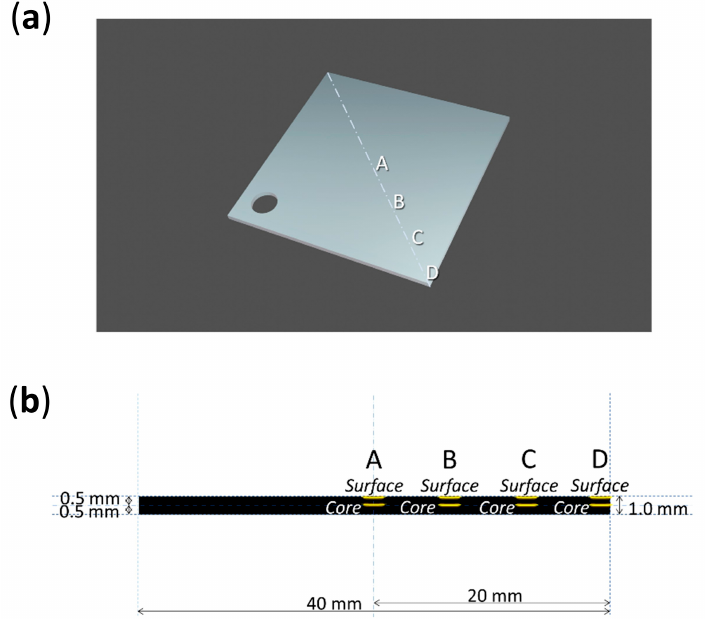
Figure 4. Sampling points ( a ) and depths ( b ) of 0-day and 10-day aged sheets.